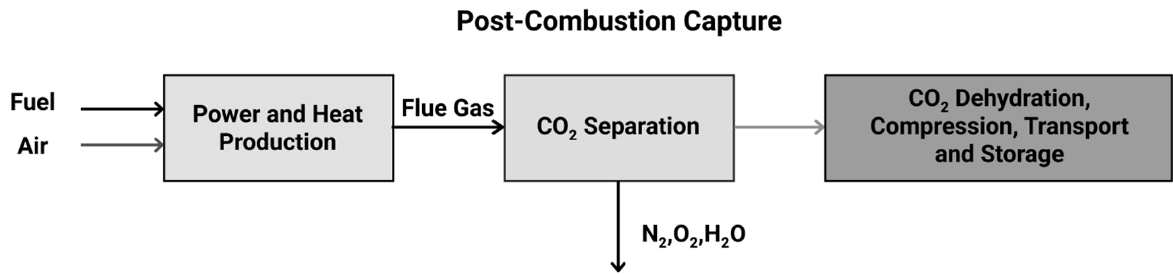
Figure 1. An overall diagram of the CCS technology for the application of the post-combustion process system.